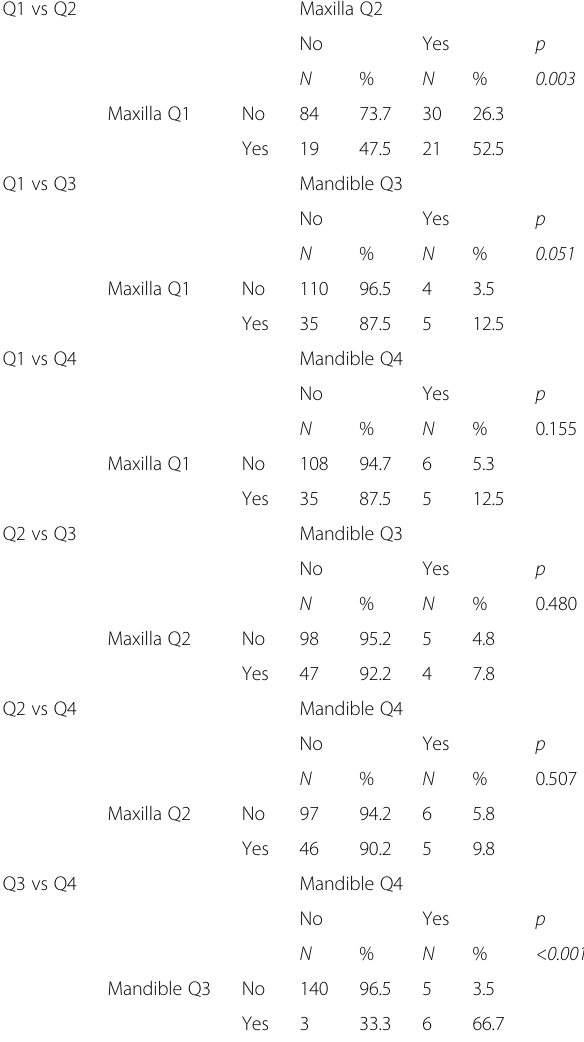
Table 7 Tooth agenesis between